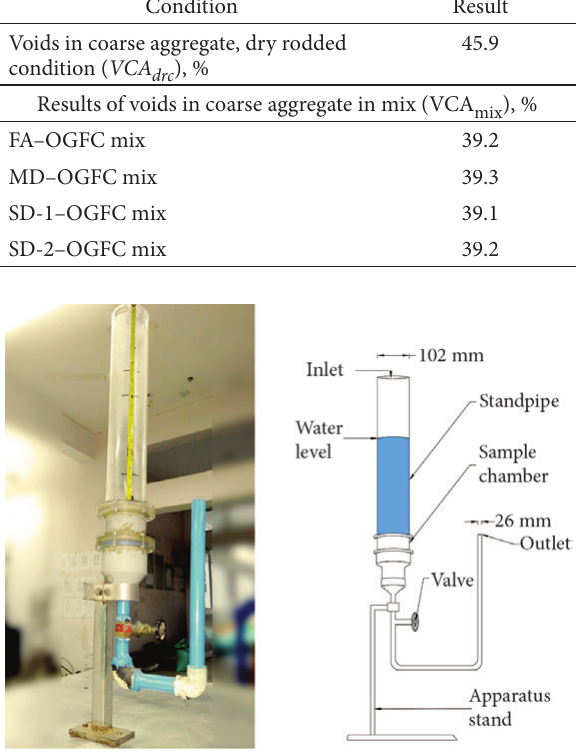
Fig. 5. Photograph and schematics of permeability testing set-up used in the